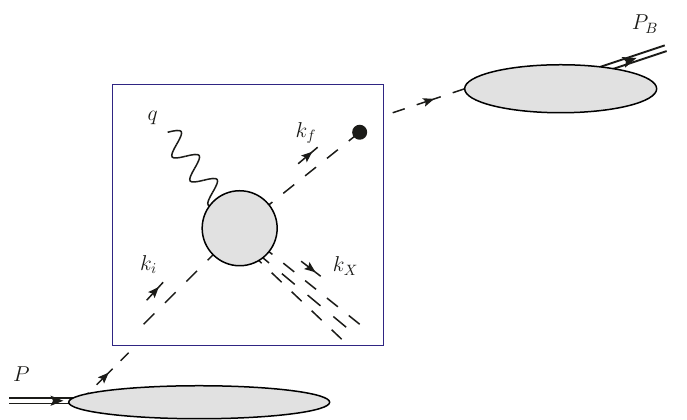
Figure 5 . Momentum labeling in the partonic subprocess. The lower blob represent the incoming hadron. The diagram in the square is the partonic subprocess of interaction of partons and the virtual photon. Dashed lines represent the (cid:13)ow of momentum. The process of fragmentation of the outgoing parton into the observed hadron B is represented by the upper